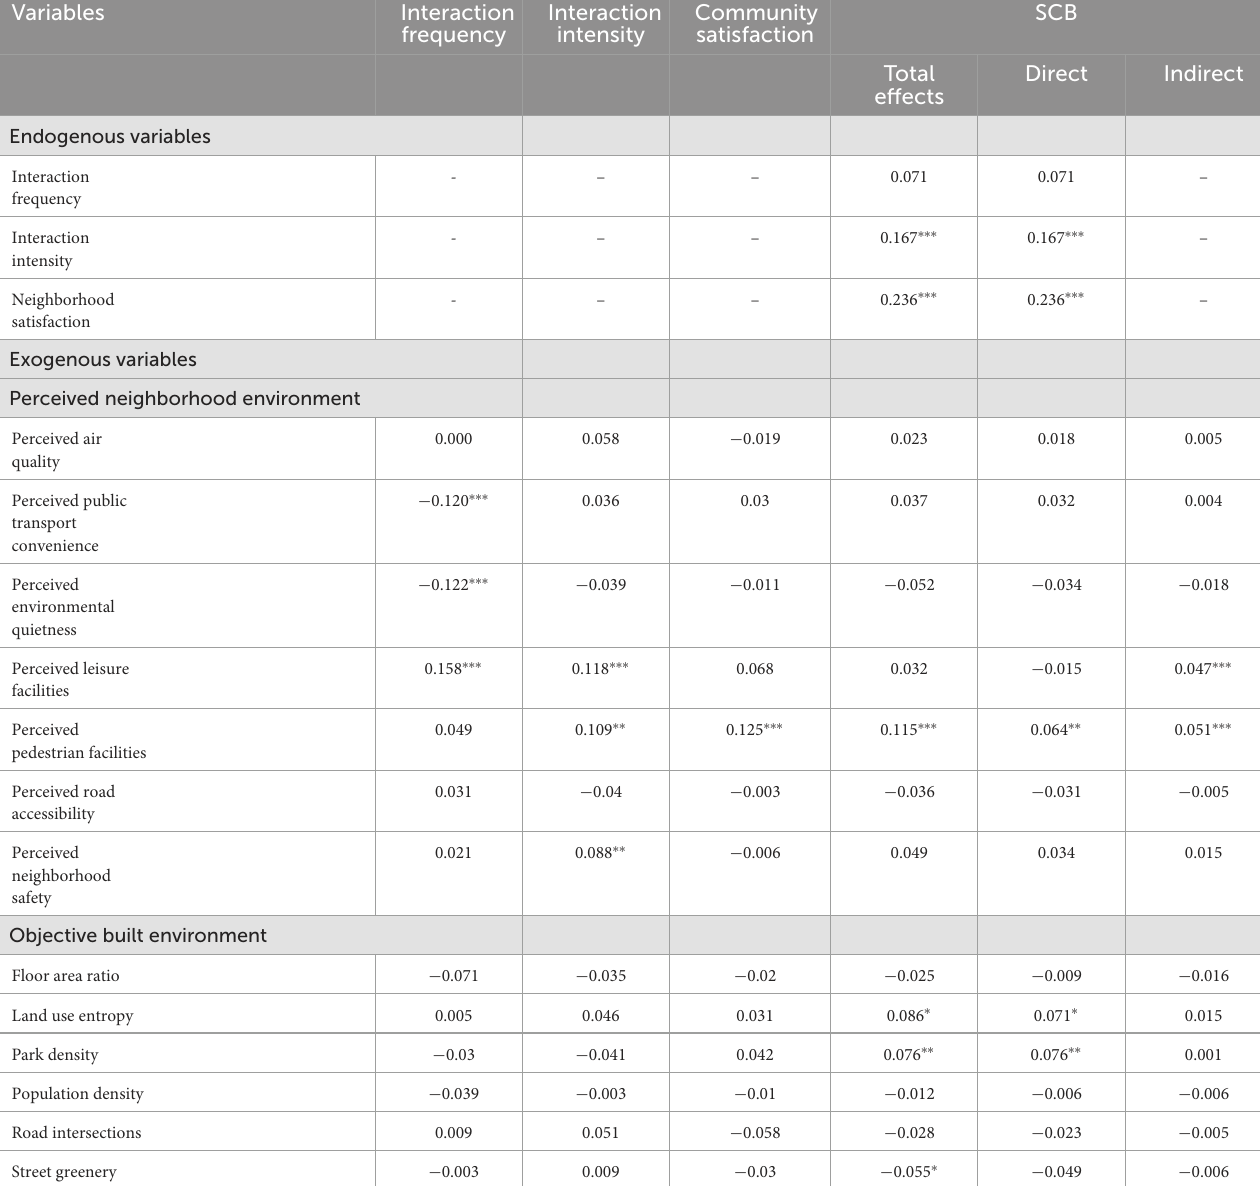
TABLE 4 Relationships between the neighborhood environment and SCB, mediated by neighborly interactions/community